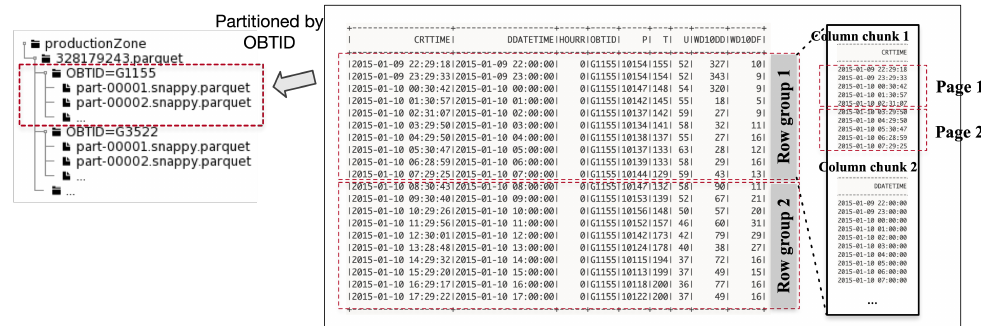
Figure 5. IoT data storage mechanism based on Apache